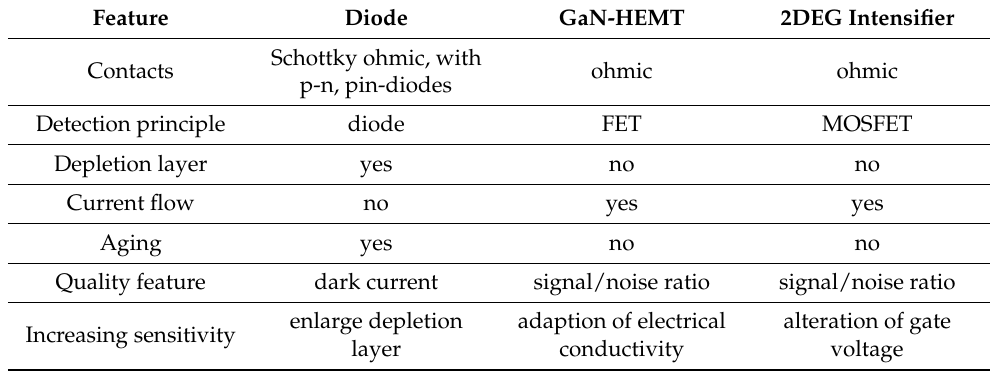
Table 1. Comparison of the functional principle of the diode, GaN-HEMT, and 2DEG intensifier. Feature Diode GaN-HEMT 2DEG Intensifier Schottky ohmic, with Contacts ohmic ohmic p-n, pin-diodes Detection